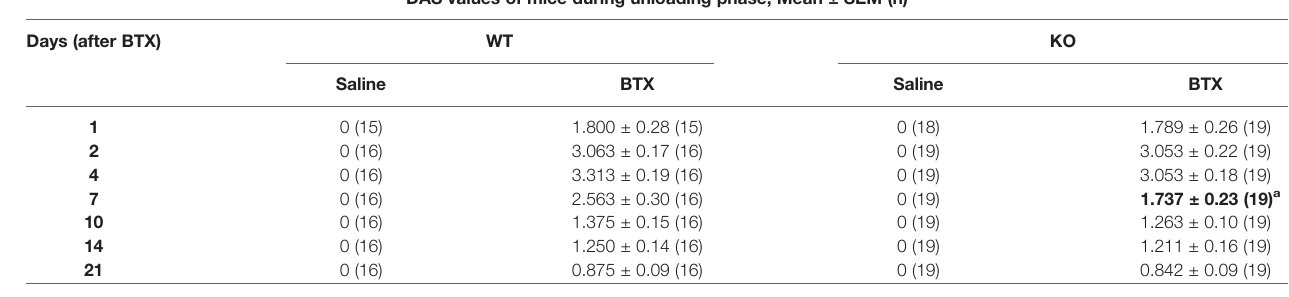
TABLE 1 | Quantitative data of DAS and Body weight in WT and KO mice injected with saline or BTX. DAS values of mice during unloading phase, Mean ± SEM (n) Days (after BTX)